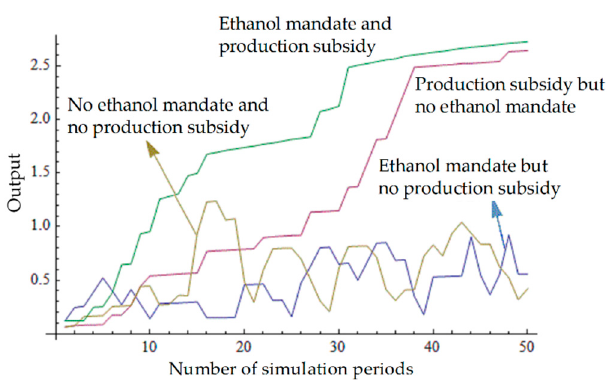
Figure 16. Impact of the ethanol mandate on the output of the fuel ethanol industry.